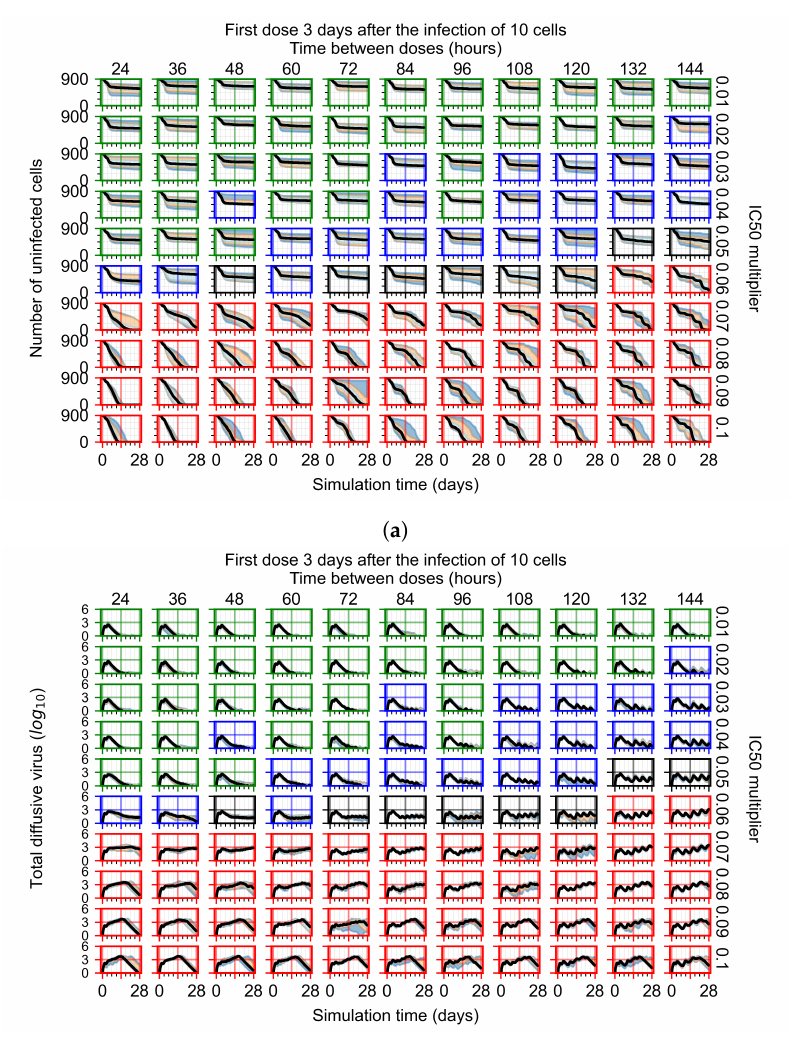
Figure 8. Treatment starts three days post the infection of 10 epithelial cells. For all subfigures, the median measurement of simulation replicas is the black line, the 0th to 100th quantiles are shaded as dark blue, 10th to 90th shaded in orange, and 25th to 75th as light blue. Rapid clearance plot axis in green, slow clearance plot axis in blue, partial containment in black, and widespread infection in red. ( a ) Uninfected cell population. ( b ) Extracellular diffusive virus; y -axis in log scale, and exponent values as tick